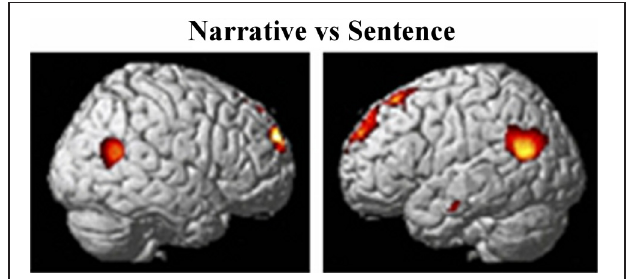
FIGURE 10 | Figure from Xu et al. (2005)—bottom panel of Figure 3 in that paper. Showing activation of the TPJ to narrative comprehension (relative to sentence comprehension). Reprinted from Xu et al. (2005). Copyright (2005) used with permission from